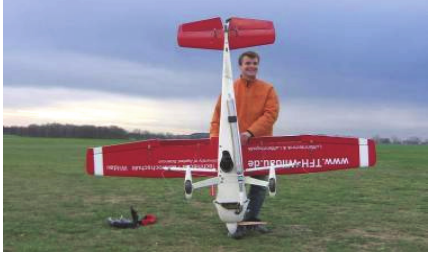
Figure 1. TFH-Bully Demonstrator